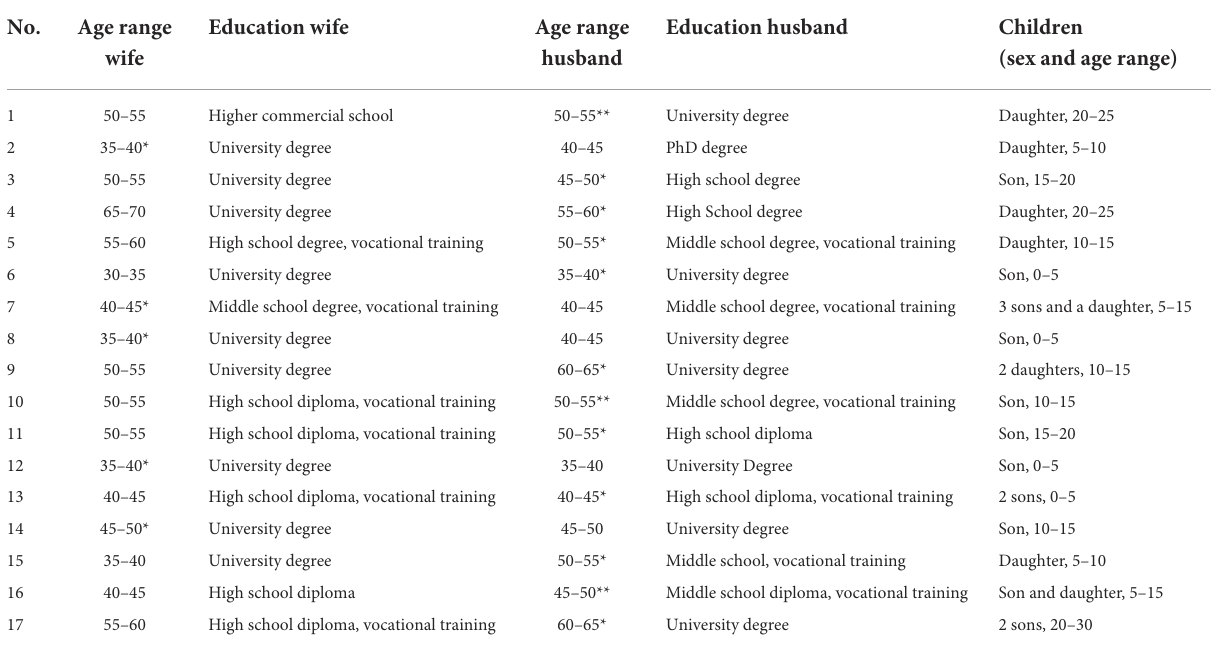
TABLE 2 Overview of participating